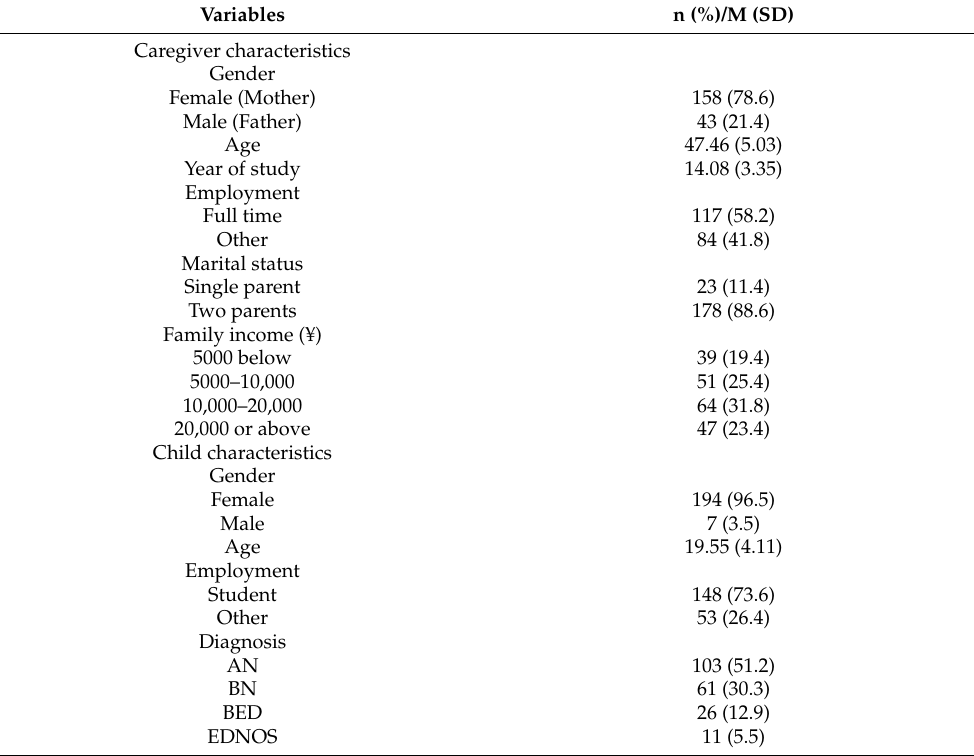
Table 1. Respondents’ demographic